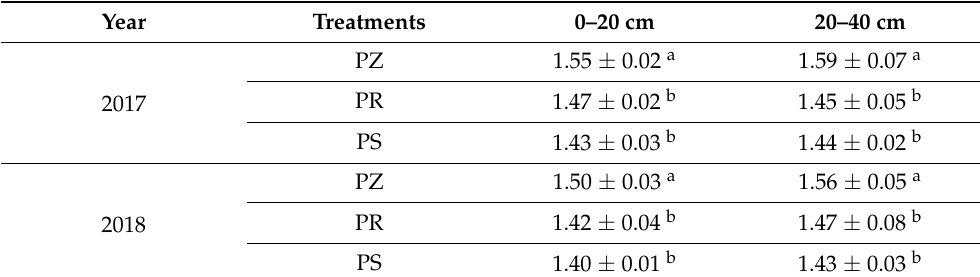
Table 2. Soil bulk density of plough layer under different tillage methods (g · cm − 3 ).